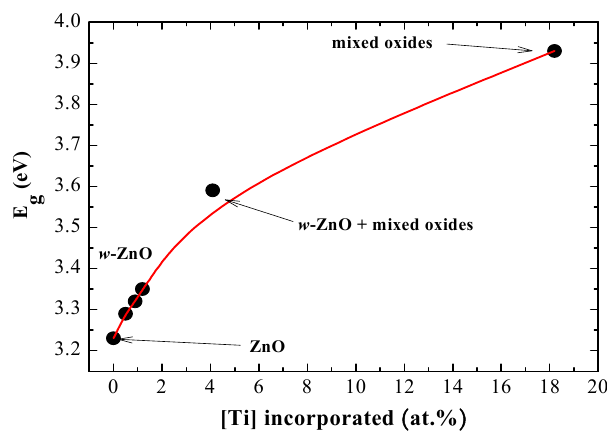
Figure 8. The energy gap, E g , for TZO films as a function of the incorporated Ti content (the solid line is drawn as a guide for the eye).